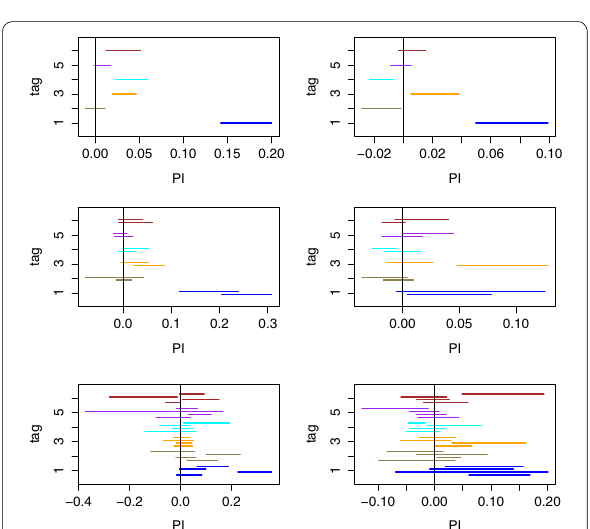
Fig. 10 Confidence intervals for the (non‑profiled) PI evaluation of Sect. 3.3 with ≈ 900 observations (top), ≈ 450 observations (middle) and ≈ 225 observations (bottom), for Users 8 (left) and 6